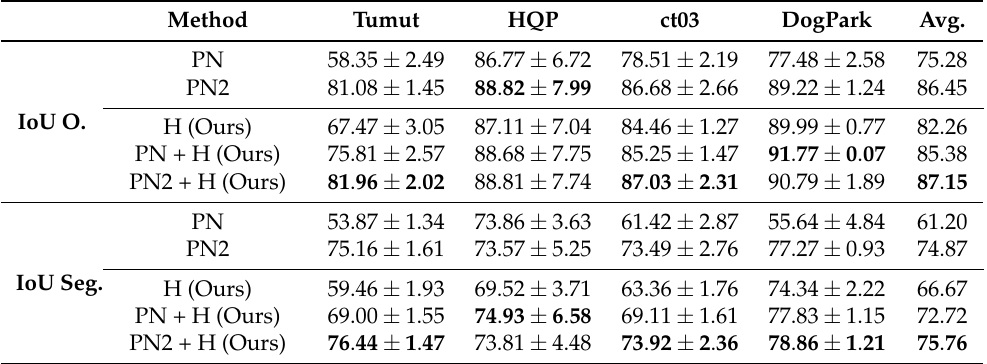
Table 2. The overall IoU (IoU O.) and average IoU over height segments (IoU Seg.) of the point cloud semantic segmentation methods under the supervised setting. We report the average results and standard deviations over the three different training and validation splits for each dataset and we highlight (in bold) the best result across different methods on each